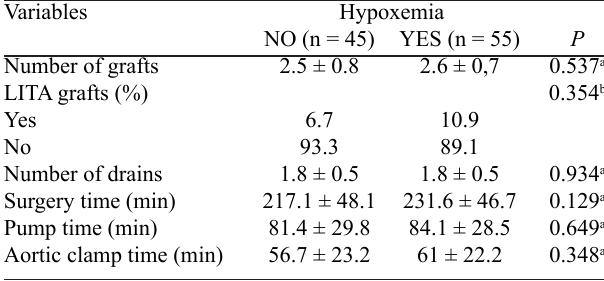
Table 2. Univariate Analysis of the intra-operative variables (n =